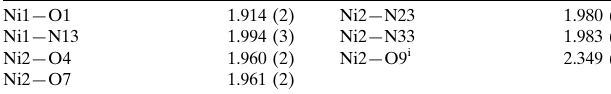
Selected bond lengths (A˚ ).